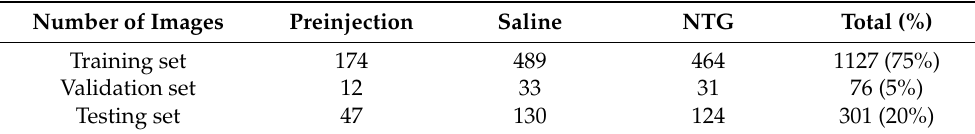
Table 1. The numbers of images taken of preinjection, saline, and NTG conditions, respectively, used as the training, validation, and testing sets. Number of Images Preinjection Saline NTG Total (%) Training set 174 489 464 1127 (75%) Validation set 12 33 31 76 (5%) Testing set